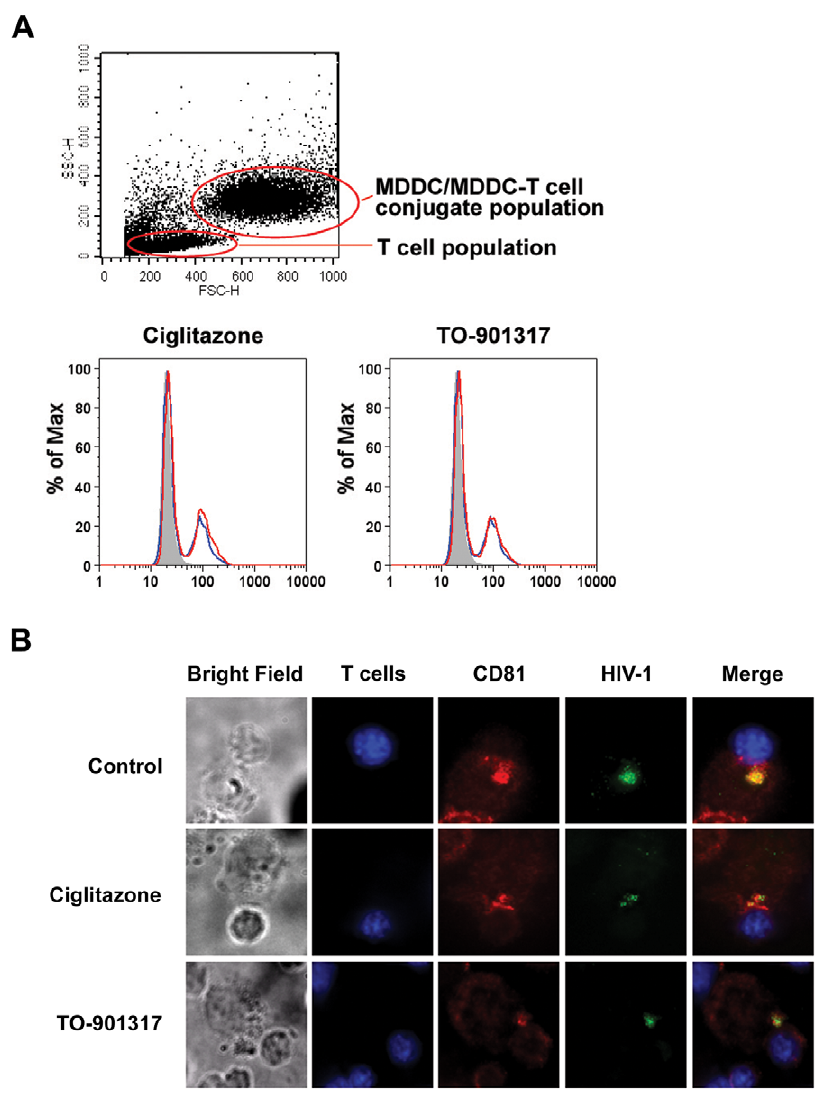
Figure 7. PPAR c and LXR ligand treatment do not prevent DC-T cell conjugate or virological synapse formation. (A) Primary autologous CD4 + T cells were labeled with the cytoplasmic dye CMTMR for 30 minutes at 37 u C, washed three times with PBS to remove excess dye, and incubated overnight at 37 u C. Following labeling, 5 6 10 5 T cells were incubated with 2.5 6 10 5 unlabeled iMDDCs for four hours at 37 u C. The conjugates were then fixed in 2% paraformaldehyde and conjugate formation was assessed by flow cytometry with gating on the MDDC population. Shaded histogram, unlabeled MDDCs without T cells. Blue line, untreated MDDCs with T cells. Red line, nuclear receptor ligand-treated MDDCs with T cells. (B) Primary autologous CD4 + T cells were labeled with the cytoplasmic dye CMCA (CellTracker Blue, Molecular Probes) for 30 minutes at 37 u C, washed three times with PBS to remove excess dye, and incubated overnight at 37 u C. 2.5 6 10 5 unlabeled LPS-matured MDDCs were incubated with 100 ng HIV-1 NL4-3 virions packaged with Vpr-EGFP for four hours at 37 u C, washed four times with PBS, and incubated with 5 6 10 5 CMCA-labeled autologous T cells for four additional hours. The cells were fixed in 1% paraformaldehyde, stained with anti-CD81-PE, and analyzed by deconvolution microscopy.